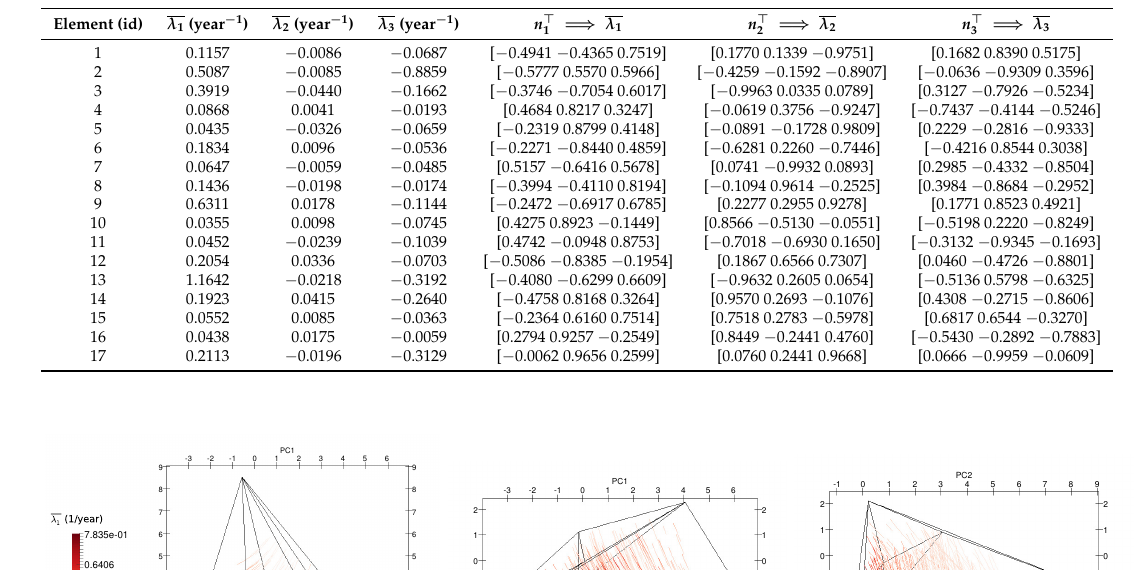
Table 3. Time-averaged eigenspace components.